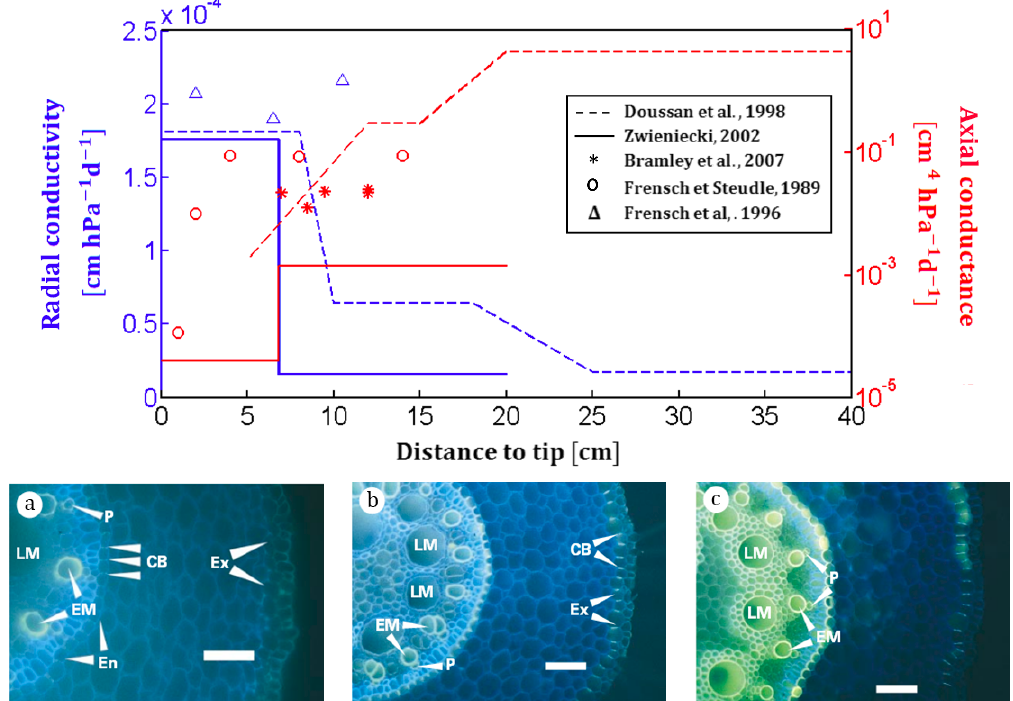
Figure 1. Top: maize radial conductivity (left axis) and axial conductance (right axis) of primary roots as measured in several studies. Bottom: maize primary root cross sections obtained at different development stages. The root cross sections are the work of Steudle and Pe- terson (1998). The scale bars are 100 microns long. Ex = exodermis, En = endodermis, CB = casparian band, P = protoxylem, EM = early metaxylem, LM = late metaxylem. (a) Immature Ex, En with CB, mature P, mature EM and immature LM; (b) mature Ex, En with asym- metrically thickened walls, mature P and EM, immature LM (c) similar to (b) with mature LM. Reproduced by courtesy of Steudle and